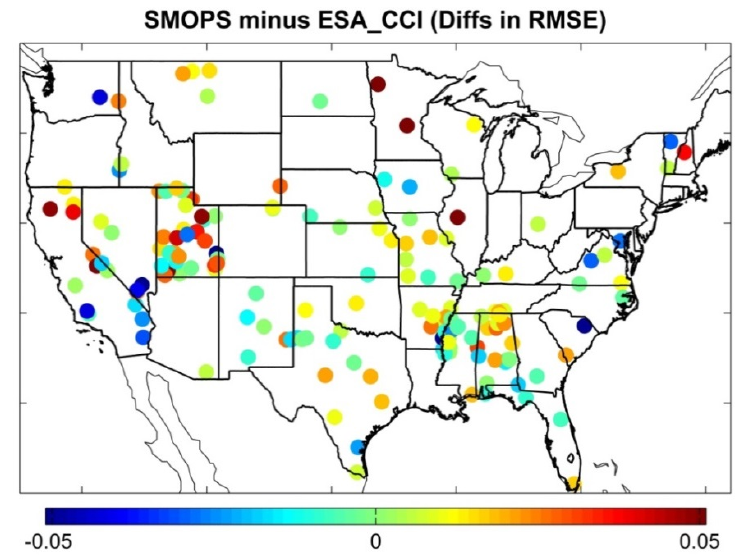
Figure 7. With respect to the quality controlled SCAN observations, differences in RMSEs (m 3 /m 3 ) between SMOPS version 3.0 and ESA_CCI version 4.5 over the 1 April 2015–31 December 2018 period. Sites in blue (red) color indicate that SMOPS is better (worse) than ESA_CCI.